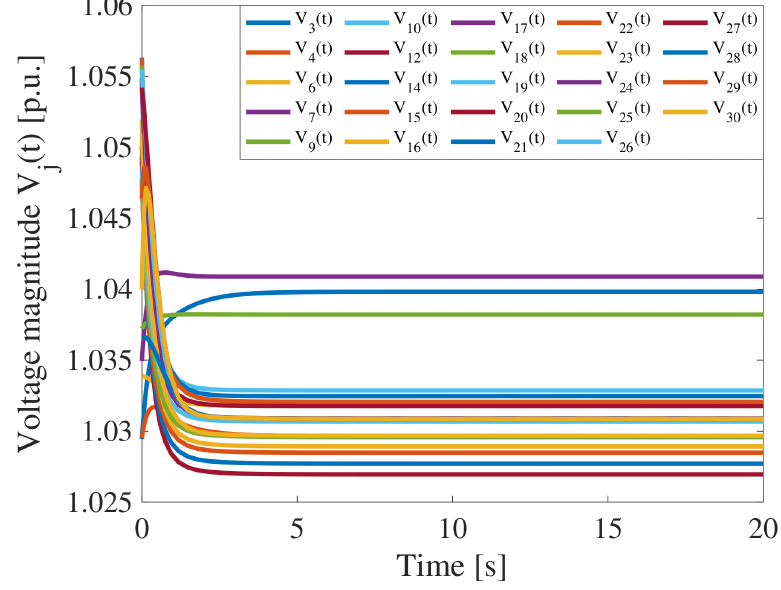
Figure 4. Time history of the voltage magnitude V j ( t ) [ p . u . ] for j ∈ N c